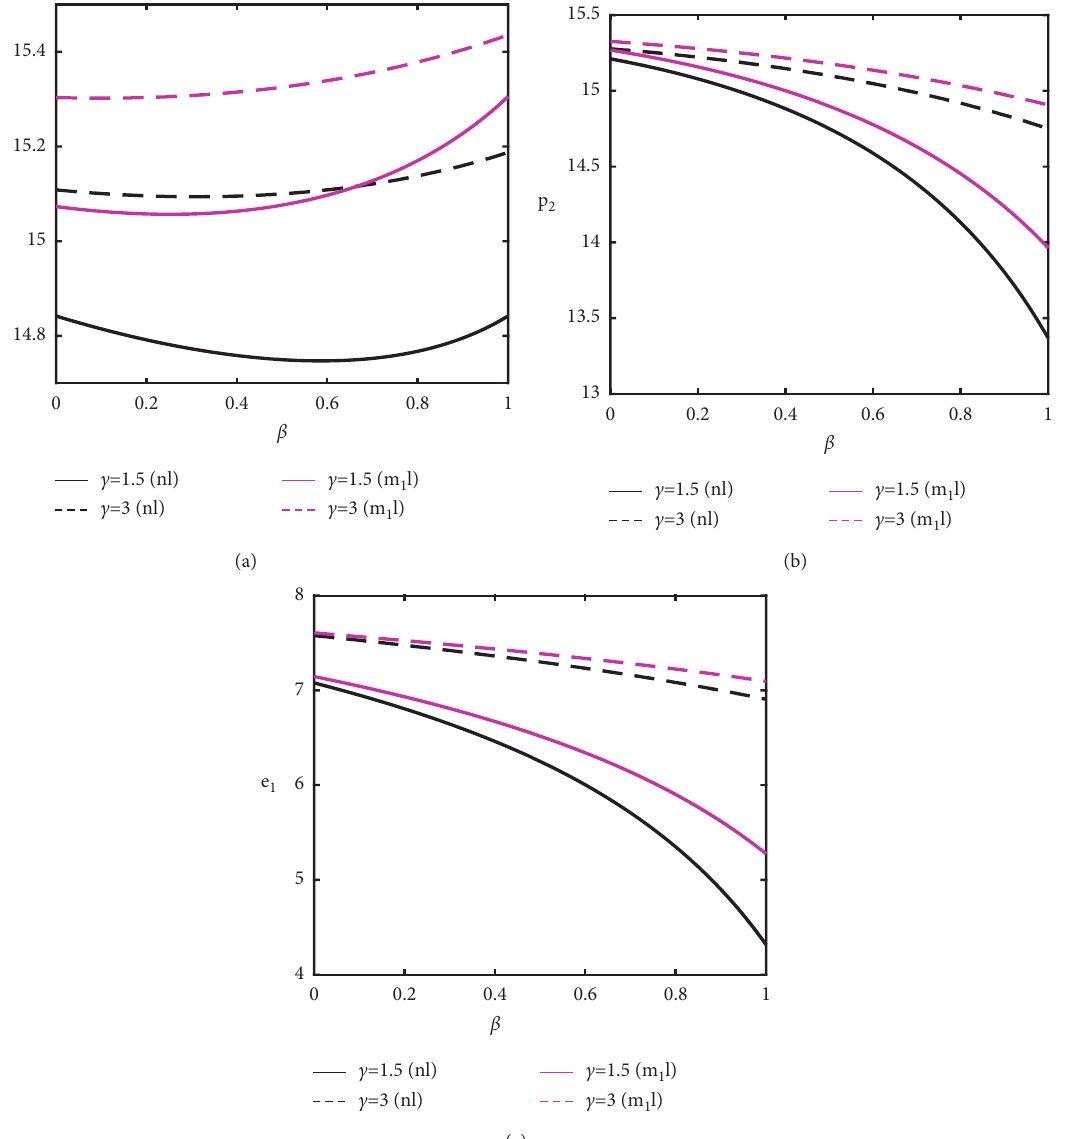
. (a) The impact of β and c on p 1